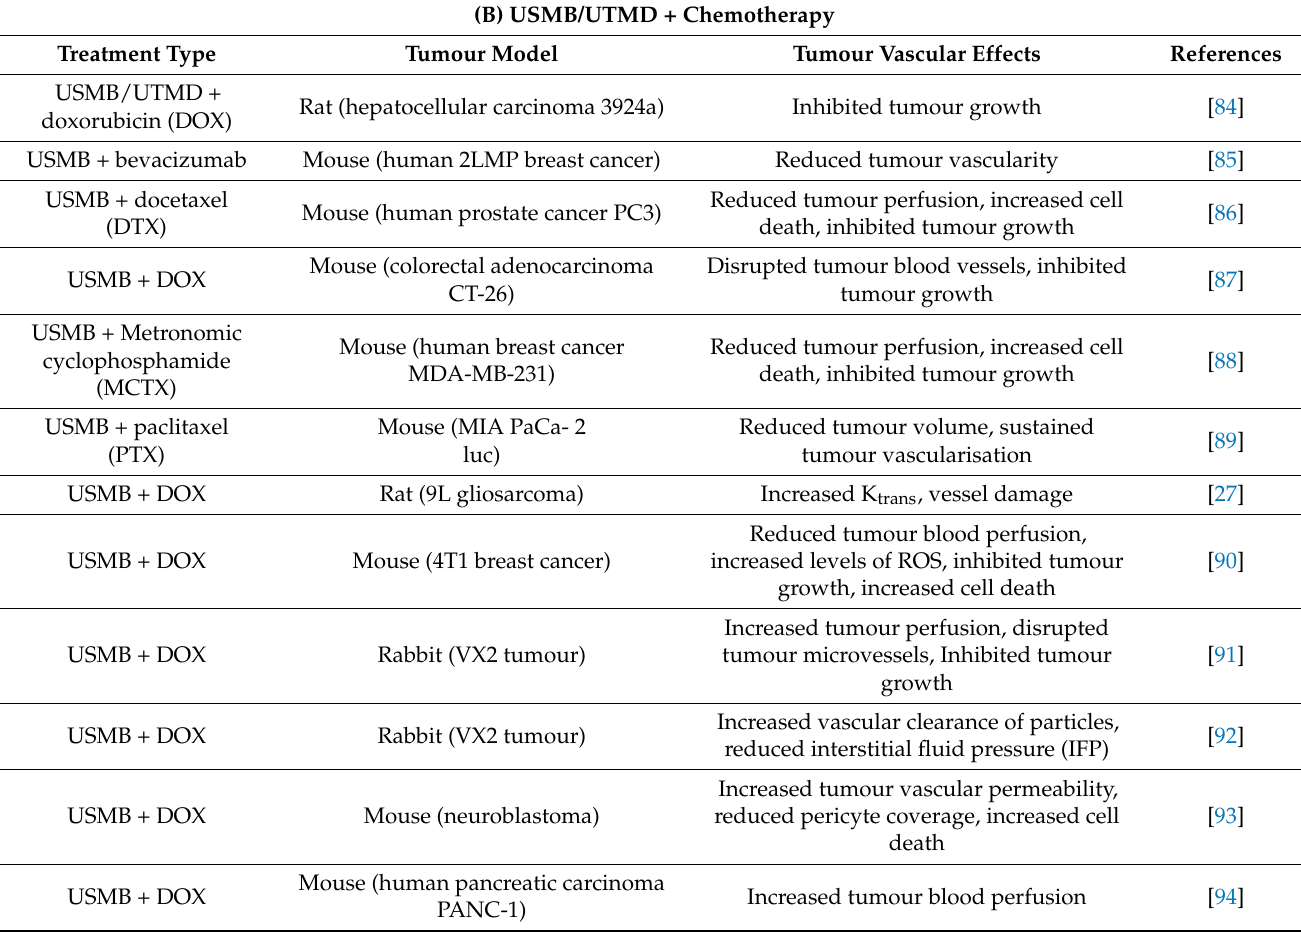
Table 1. Cont. (B) USMB/UTMD +